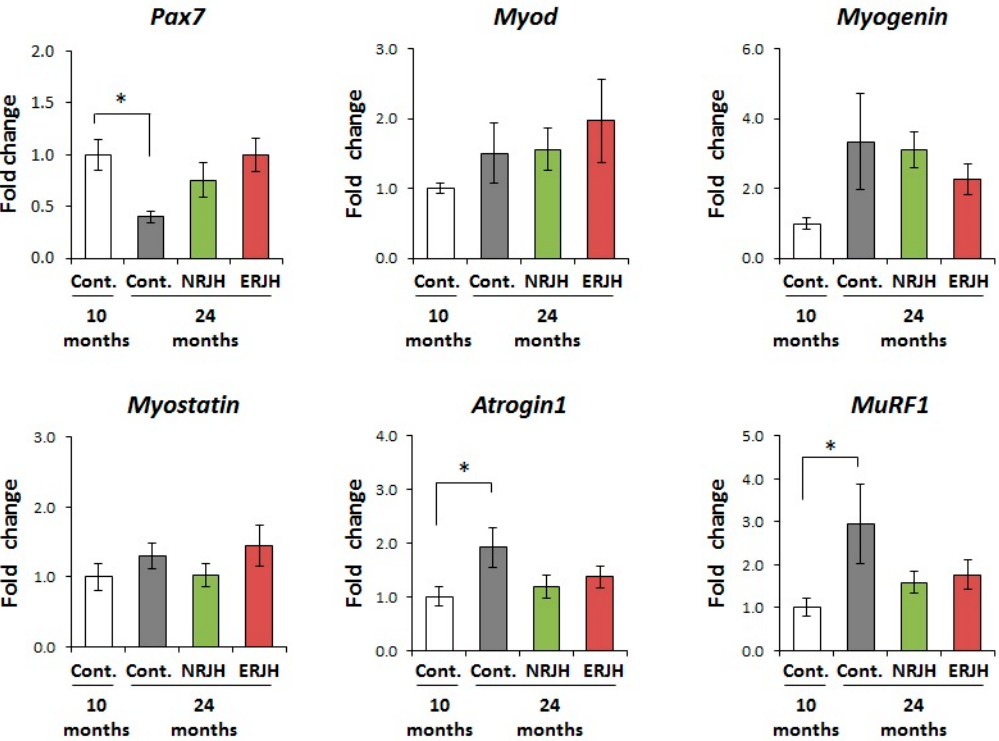
Figure 4. Effects of RJ on the mRNA expression of muscle differentiation, regeneration, and atrophy-related genes in genetically heterogeneous mice. The mRNA expressions of pax7, Myo D, Myogenin, Myostatin, Atrogin1, and MuRF1 in the gastrocnemius muscle were measured by real-time reverse transcription polymerase chain reaction. The data were normalized with respect to a house-keeping gene and shown as the mean fold-change ± SEM ( n = 5) with respect to the control group at 10 months of age (Control, 10 months). P values were determined by the Kruskal–Wallis test (post-hoc Dunn’s multiple comparisons test). * P < 0.05.